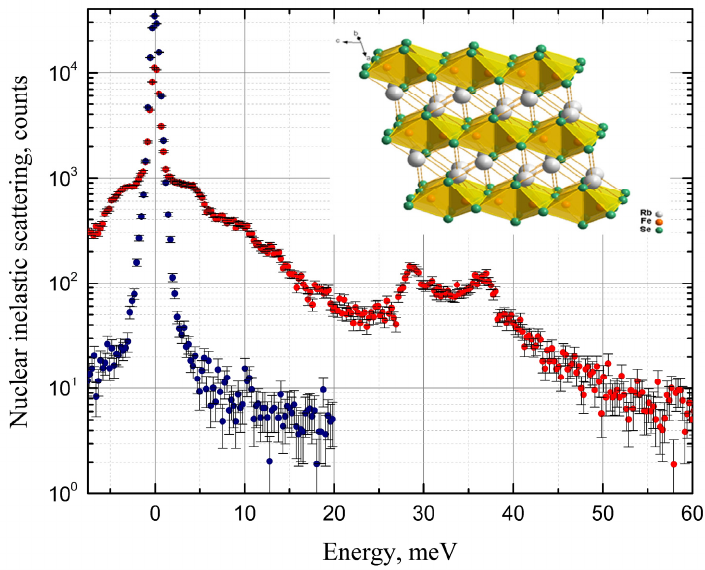
Figure 1. 57 Fe nuclear inelastic scattering spectrum of RbFeSe 2 (red dots) and instrumental function (blue dots). The inset displays a fragment of the RbFeSe 2 crystal structure showing quasi-one-dimensional structure of edge-sharing (FeSe 4 ) tetrahedra.